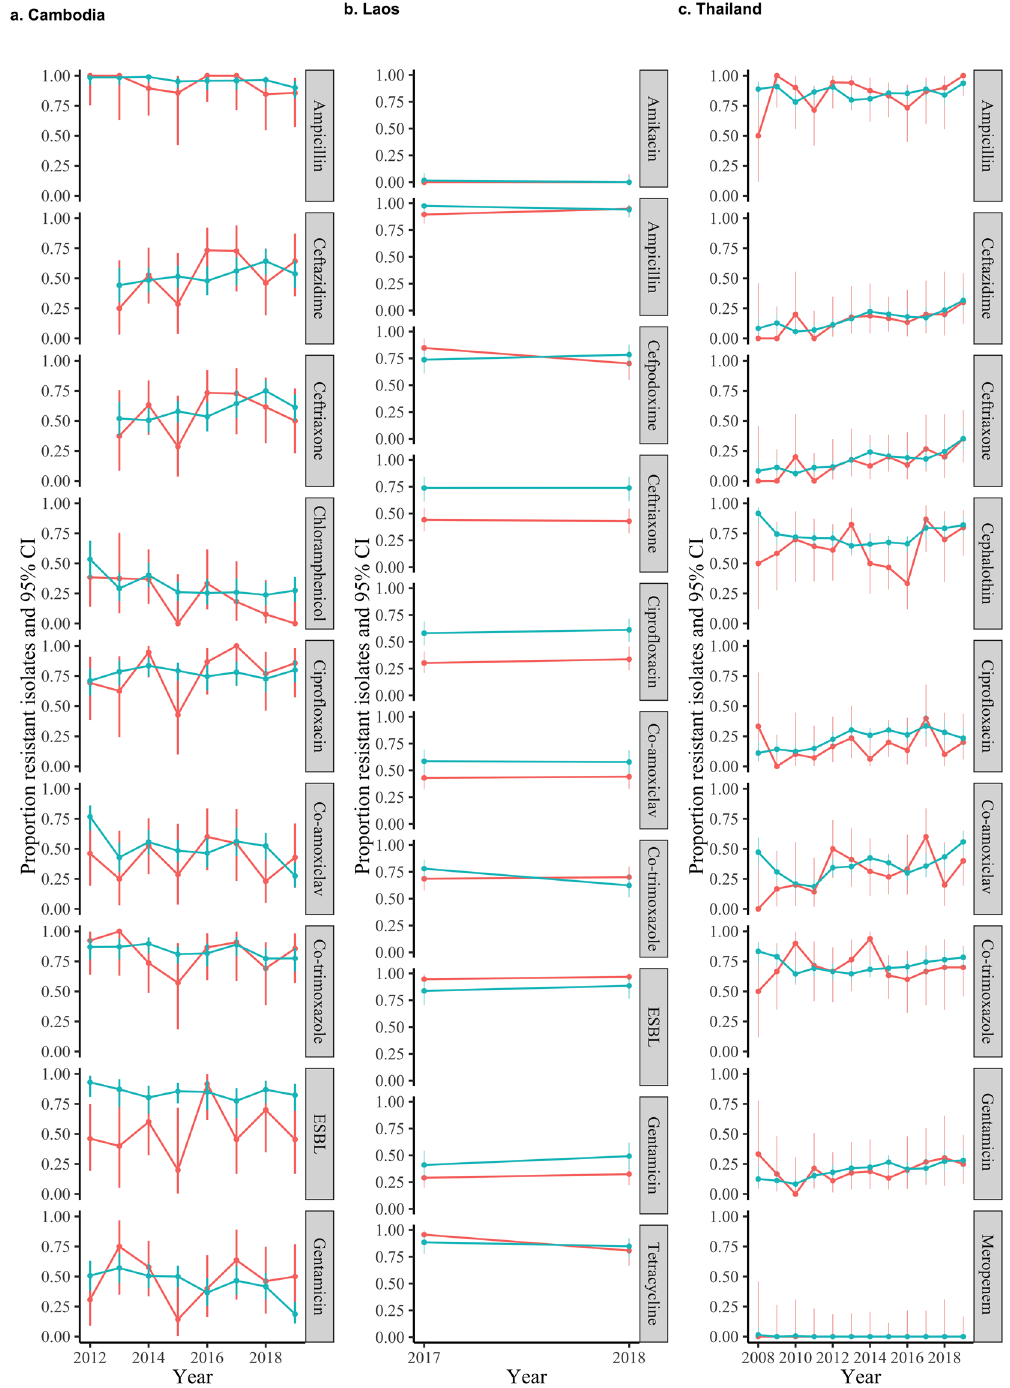
Figure 5. Resistance prevalence in E. coli in blood versus non-blood cultures in three hospitals/programmes in